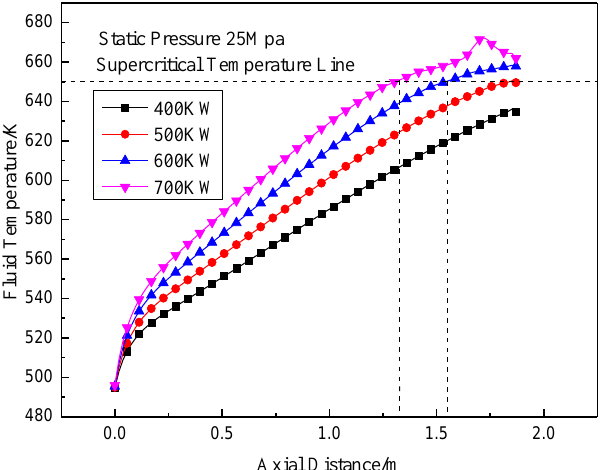
Figure 10. Fluid temperature distribution in the heating section under di ff erent heating